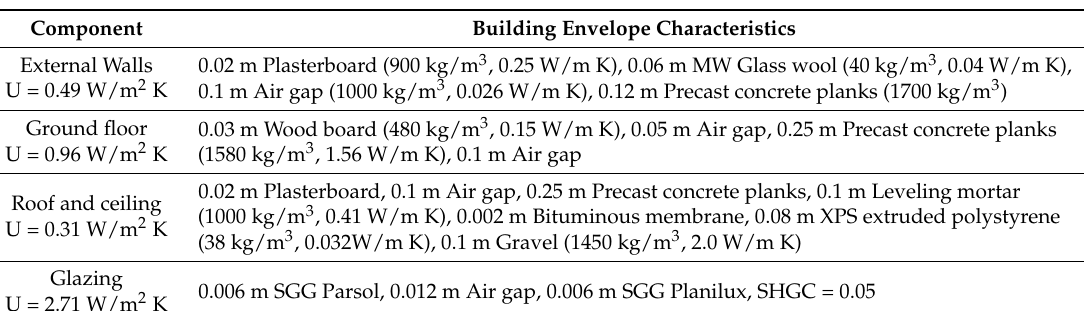
Figure 2. Virtual model of the entire facility with roof-integrated solar pergola. Solar pergola total area: 1231 m 2 .